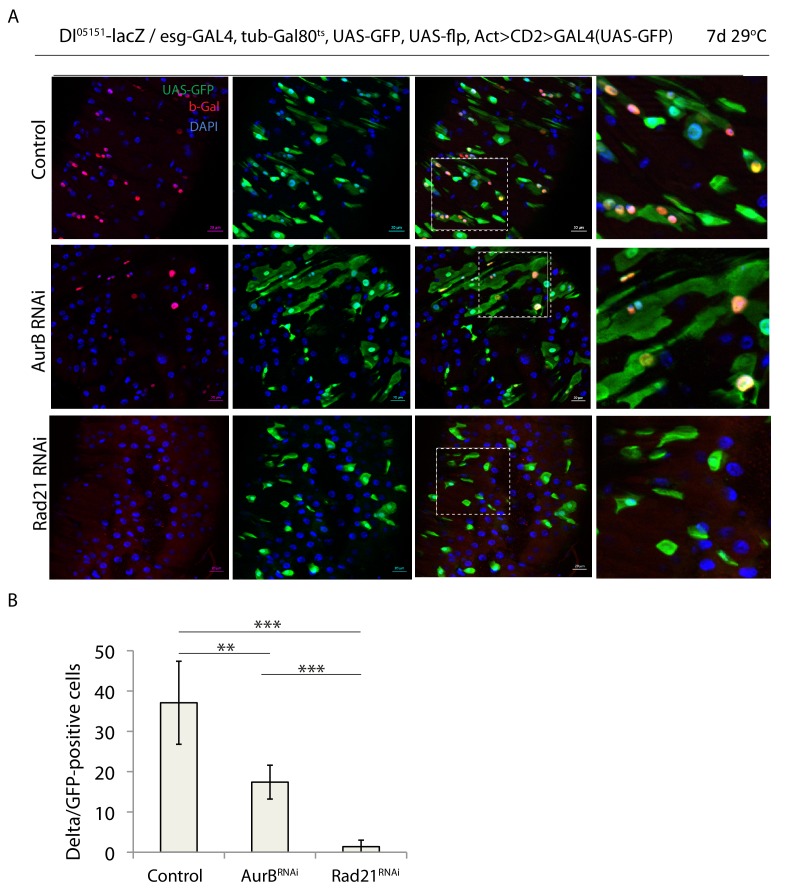
Downregulation of AurB and Rad21 differentially affect ISC maintenance.(A) esg-F/O/Delta-lacZ midguts expressing UAS-GFP alone (control), aurBRNAi or expressing rad21RNAi. Samples were stained for GFP and b-gal. (B) Quantification of GFP-positive/Delta-lacZ-positive cells from A. (n = 1489, 1522, 733), ANOVA. **p<0.01, ***p<0.001. Scale bars, 20 µm.